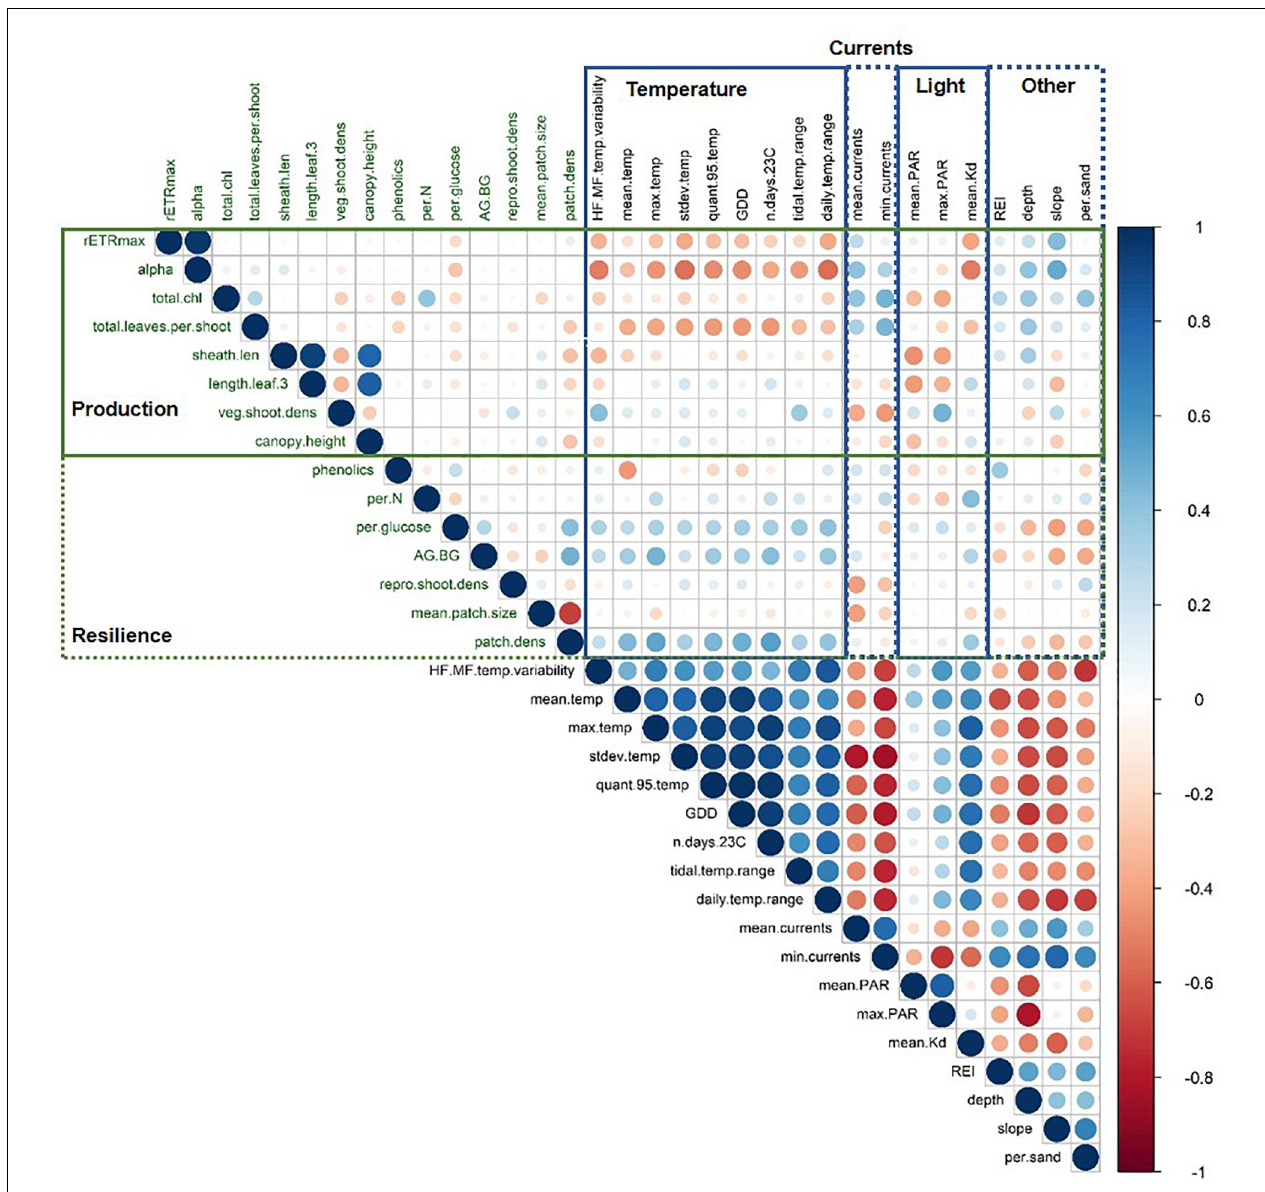
FIGURE 3 | Matrix of Pearson’s correlation coefficients between all environmental and biological metrics. Points are colored and sized according to the value of the Pearson’s correlation coefficient. Biological metrics are shown in green and split into those associated with production and resilience. Environmental metrics are in black and categorized as indicated. Variable abbreviations are defined in Table 1 . Plot created using the corrplot package in R (Wei and Simko,